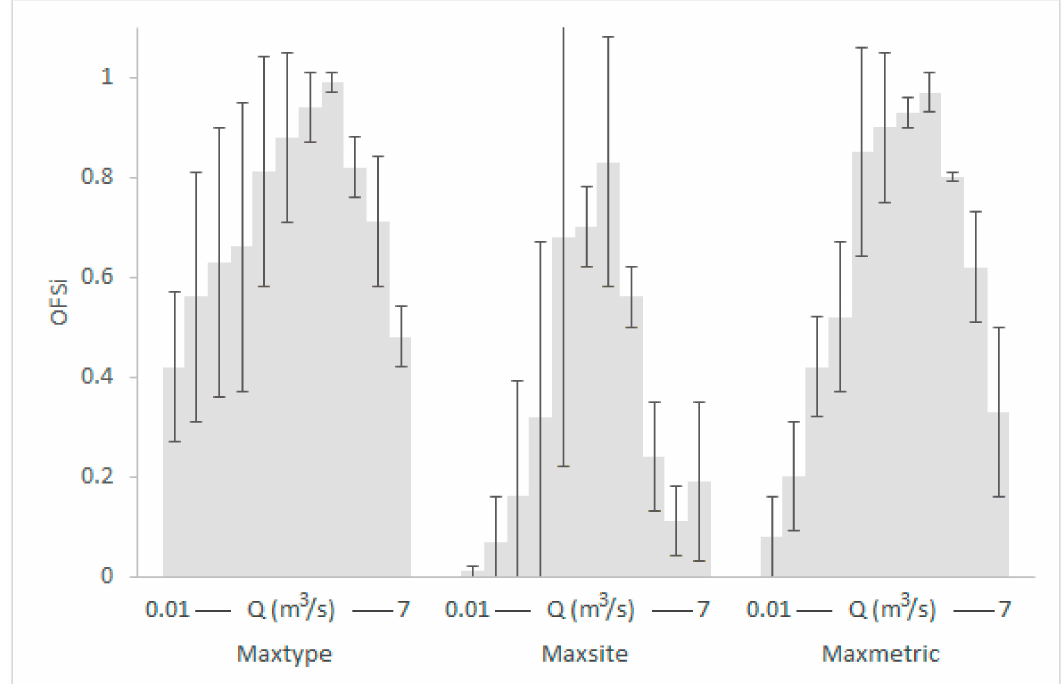
Figure 5. Graphical representation of the typological OFS means (gray shaded) and standard deviations within the various κ -normalization alternatives for the Parapeiros reach. The OFS values of RM1-2 and RM4 types for each discharge (Q) have been